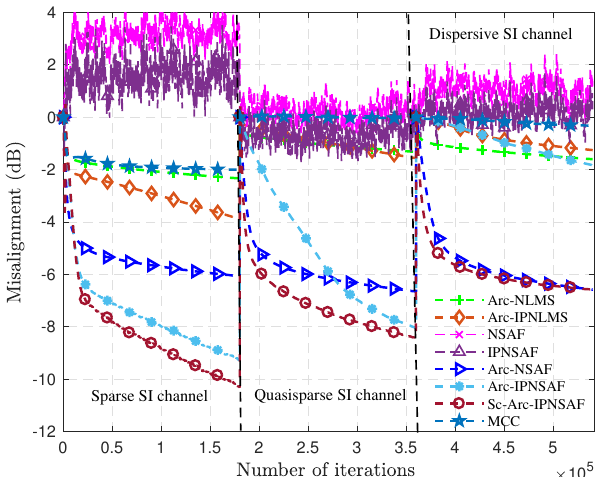
Figure 8. NMSD of different algorithms in sparse, quasisparse, and dispersive SI channels, and the input signal is the BPSK signal.